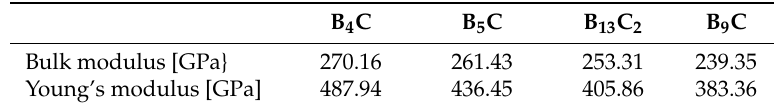
Table 3. Computed bulk and Young’s moduli of boron carbides with boron concentrations between x B = 0.8 and x B = 0.9.